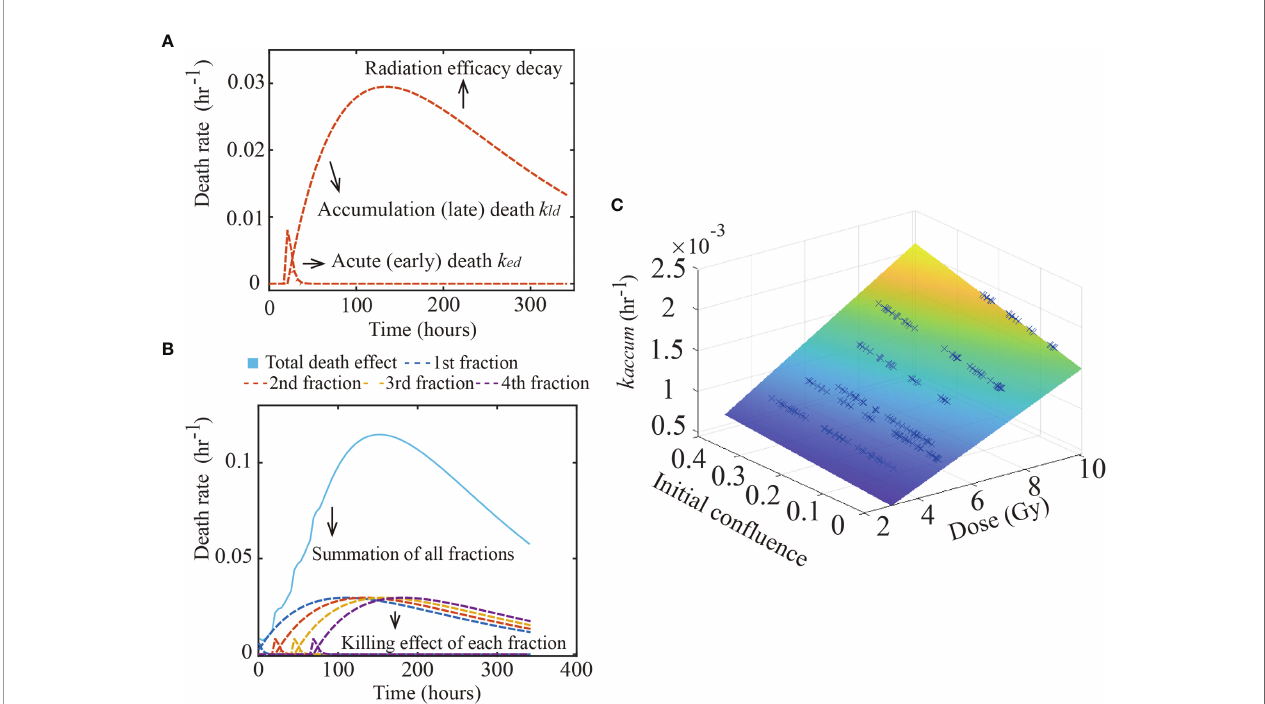
FIGURE 2 | Glioma death rate over time. The fi gure shows the calibrated early and late death parameters of 9L cell line. Panel (A) shows how the early and late death rates change as a function of time from a single treatment. After radiation, the acute death spikes and decreases as the double strand breaks are repaired. In contrast, misrepaired DSBs accumulate within the cells ’ genome, causing the late death rate to increase over time, before it eventually decreases as the radiation ef fi cacy decays. Panel (B) shows the summation (labeled by the blue solid line) of four fractions (each fraction labeled as dashed lines) irradiated every 24 hours starting from time 0. Each fraction has the same effect as in panel (A) . Panel (C) illustrates the hypothesis captured by Eq. (7); namely, that k accum ( D , N 0 ) is a function of both dose and initial con fl uence. Each blue cross indicates the calibrated result of one replicate of the 9L cell